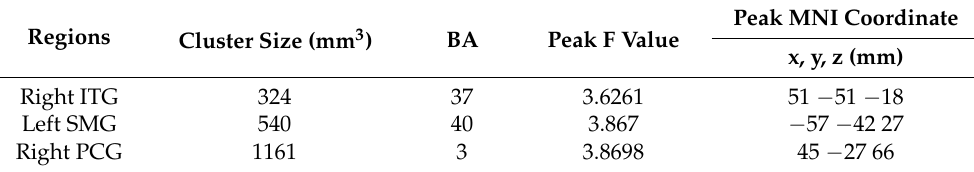
Figure 2. Decreased connections in visual network and its correlation to retinal vascular structures in cognitive impairments. ( A − C ) showed the abnormal changes in visual network in CI group: greater decreases in CI group compared with HC group, such as right inferior temporal gyrus, left supramarginal gyrus and right postcentral gyrus. The functional connectivity strength in left supramarginal gyrus was associated with Intra-layer VD (6 × 6 mm, ( D )), Completed VD (6 × 6 mm, ( E )) and Completed VD (6 × 6 mm, ( F )), while the functional connectivity strength in right postcentral gyrus was related to Intra-layer PD (3 × 3 mm, ( G )) and Completed PD (3 × 3 mm, ( H )) in CI group. Statistically significant differences were defined as p < 0.05, indicated by the symbol *. Table 3. Different brain regions in visual network between HC and CI